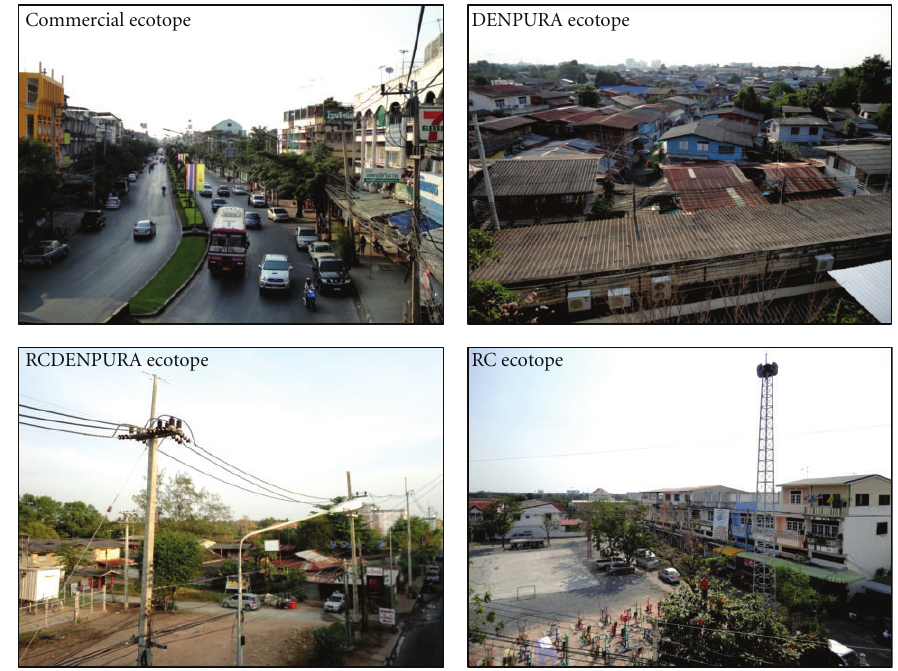
Figure 3: The four di ff erent characterized